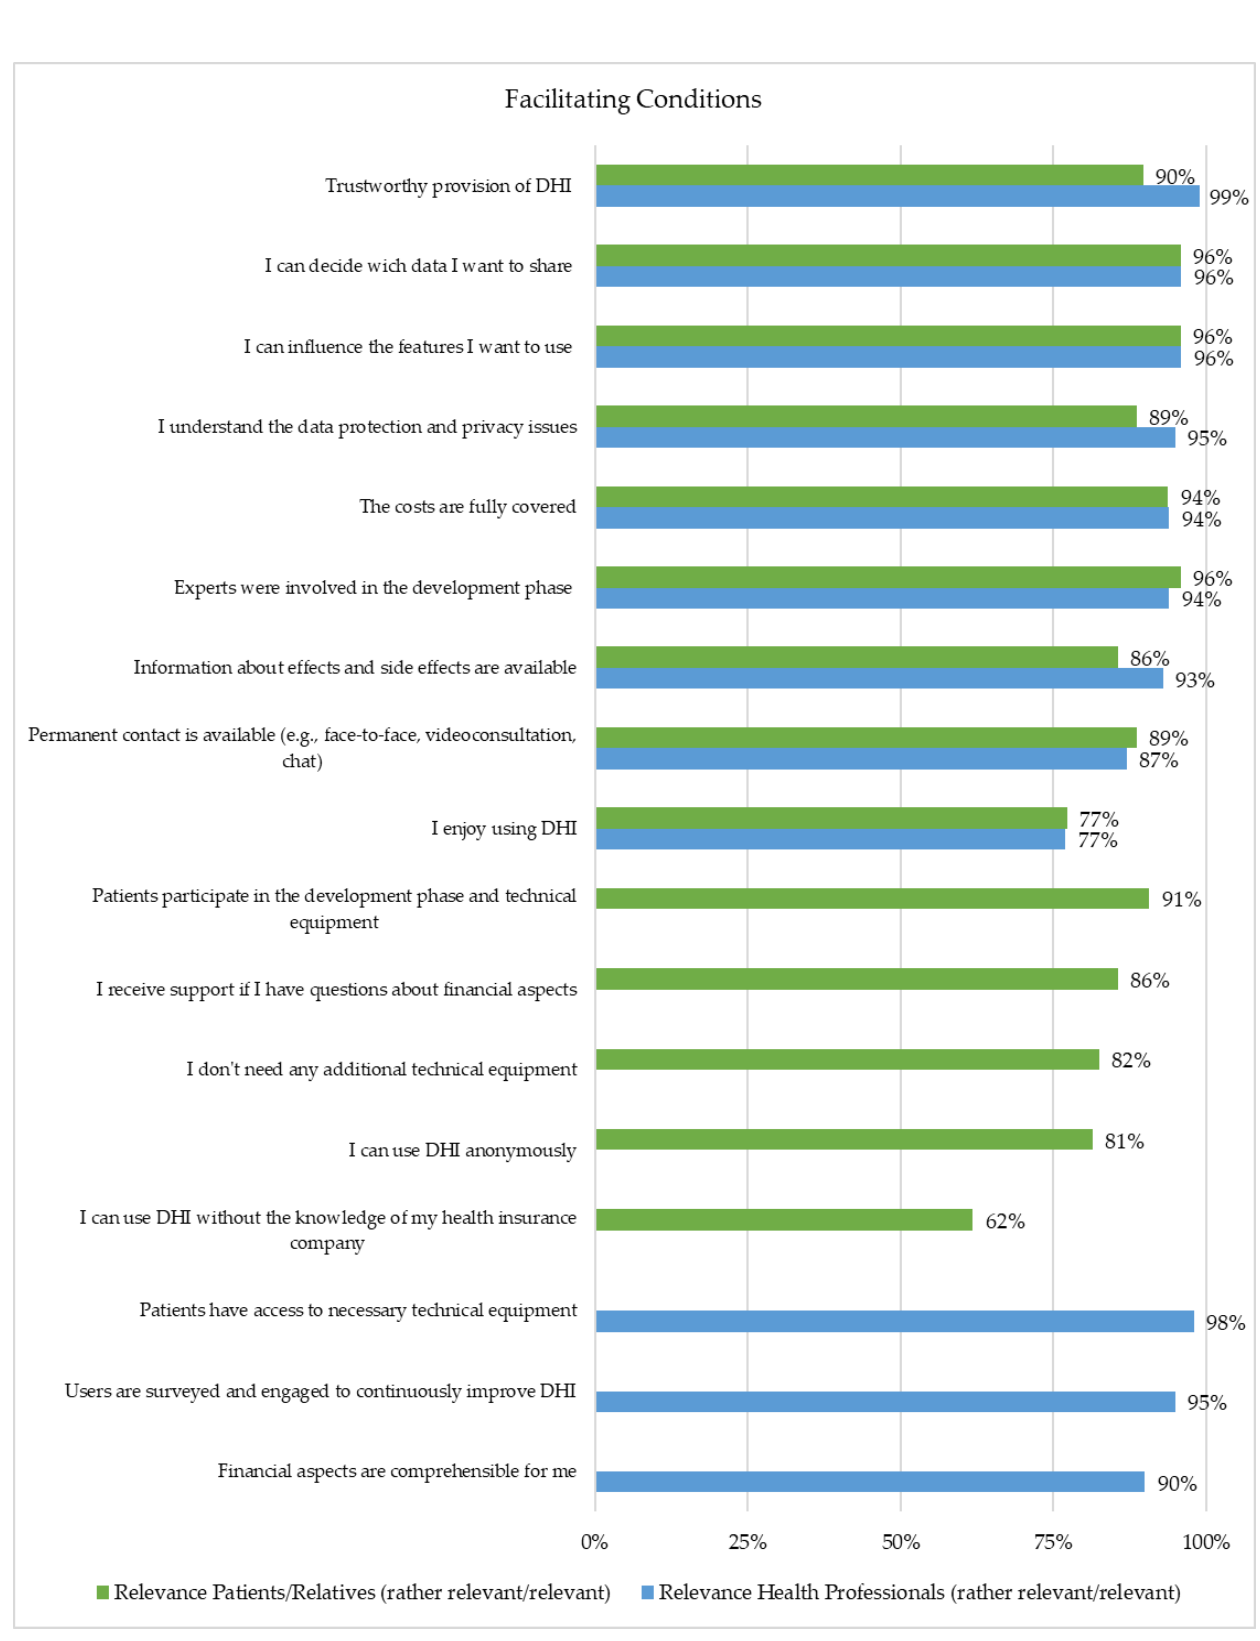
Figure 4. Representation of the Facilitating Conditions (Patients/Relatives ( n = 97) and Health Profes- sionals ( n = 229)).